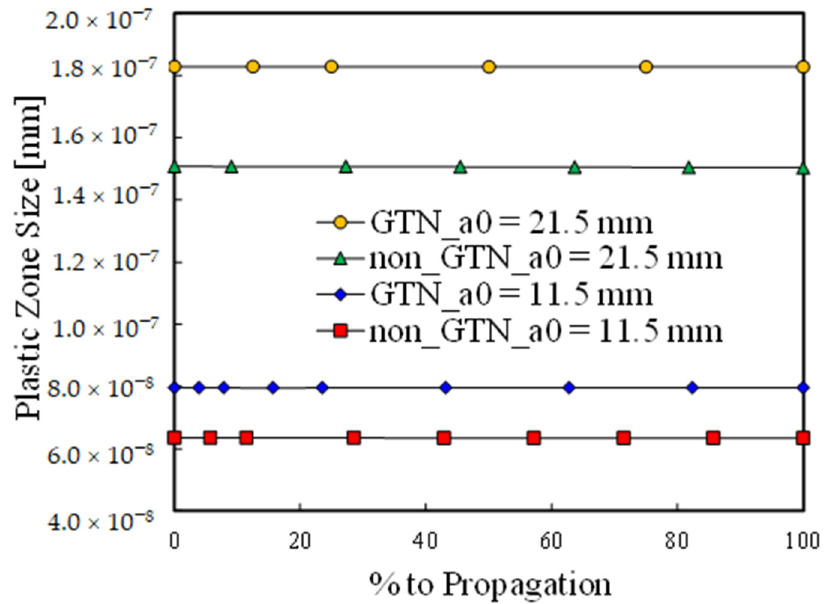
Figure 6. Size of the plastic zone at the crack tip evaluated for a 0 = 11.5 mm and a 0 = 21.5 mm considering both models—with and without GTN.